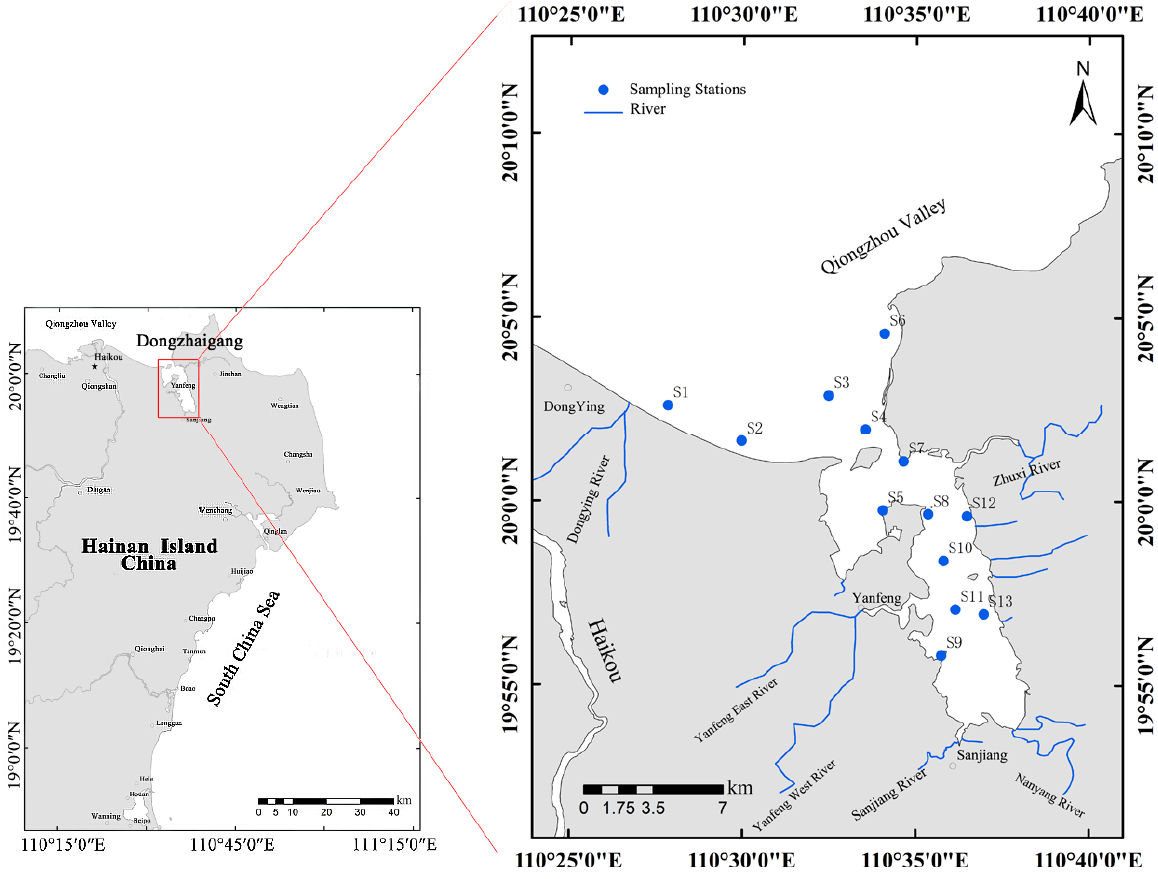
Figure 1. Sampling stations in the study